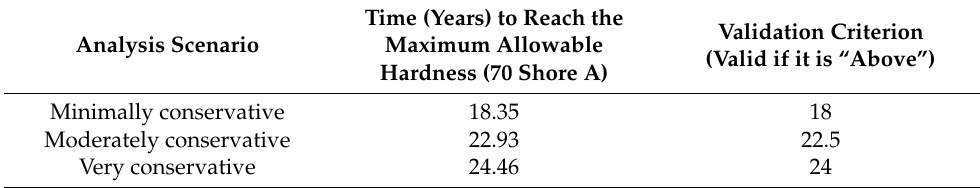
Table 7. Results of the application of the Arrhenius-based model and validation.